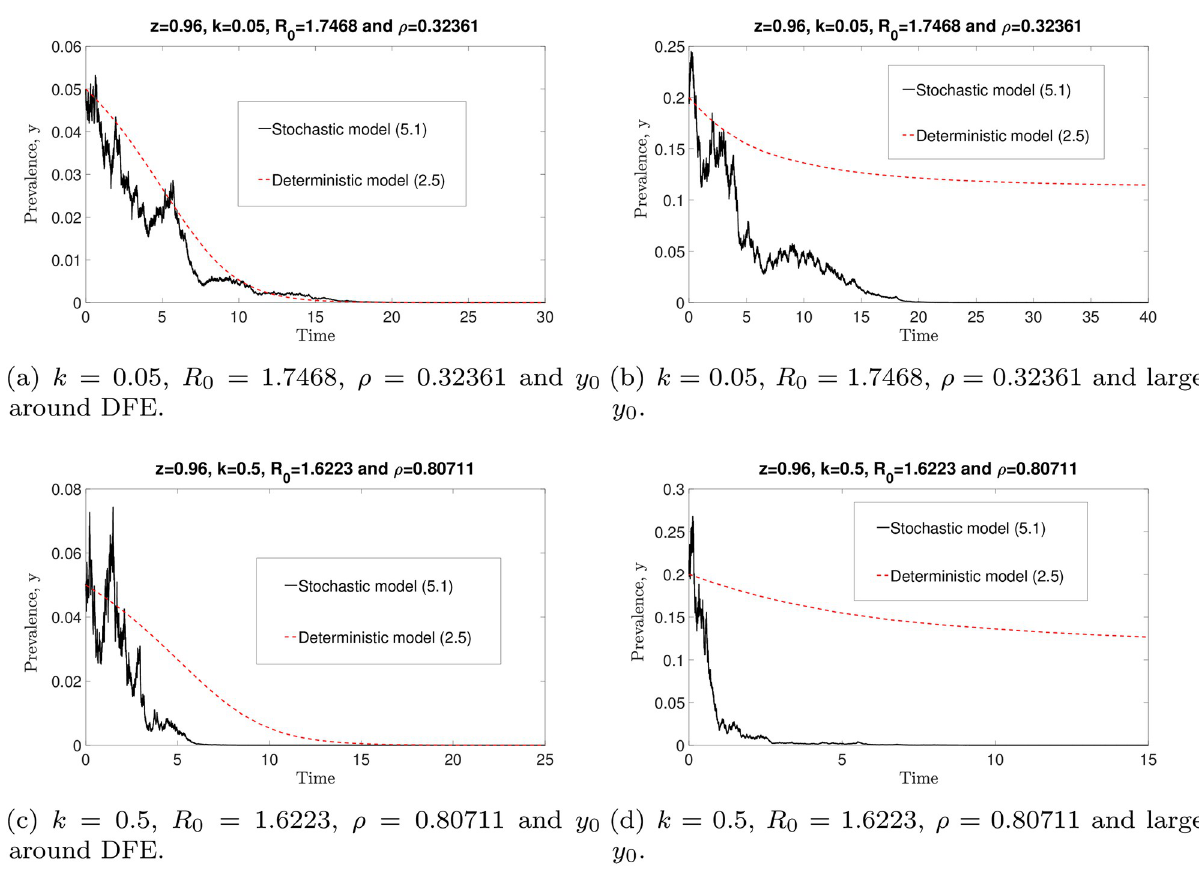
Fig 15. Comparisons of the stochastic (23) and deterministic (5) models with arbitrary k , ρ and y 0 values. By choosing parameter values that satisfy the conditions in Theorem 3, all solutions of the stochastic model (23) with arbitrary k and y 0 eventually converge to zero. However, if y 0 is sufficiently large, the stochastic and deterministic models produce conflicting results. That is, solutions of the stochastic model approach zero, whereas solutions of the deterministic model remain endemic.